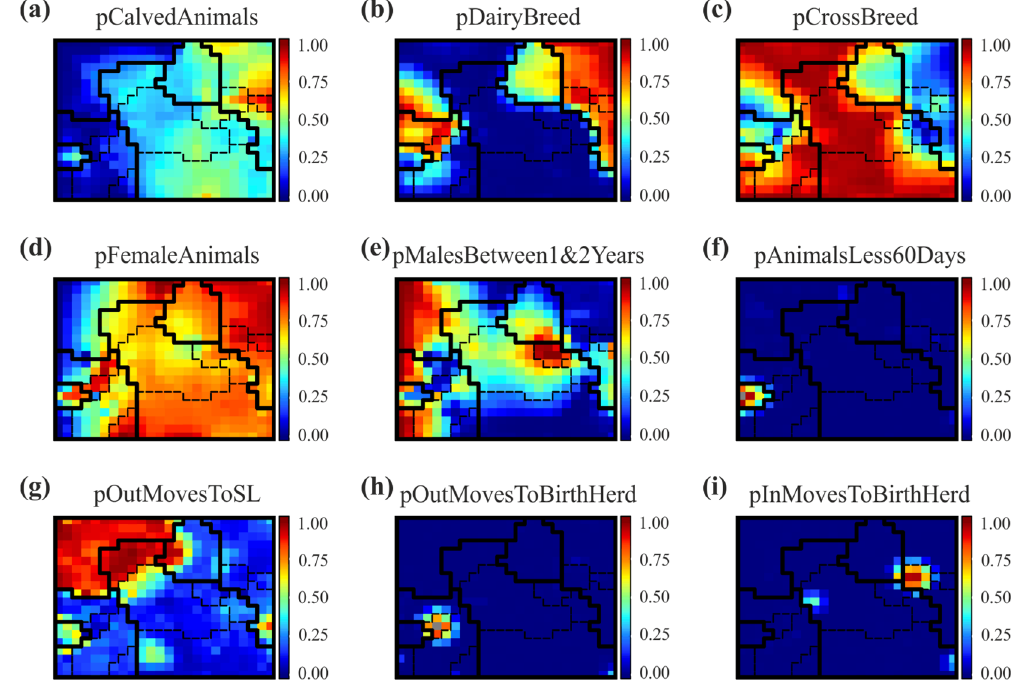
Figure 3. Component planes of the final self-organising map for the nine iteratively selected input variables, resulting in comprehensive discrimination of Irish cattle herds by 17 herd types (Fig. 4). Class boundaries for the six main herd types identified are represented as bold black lines, whereas sub-classes are separated by dashed lines. Herds are each represented by the same pixel in the nine panels. Colour coding shows the values of the respective variable in a given